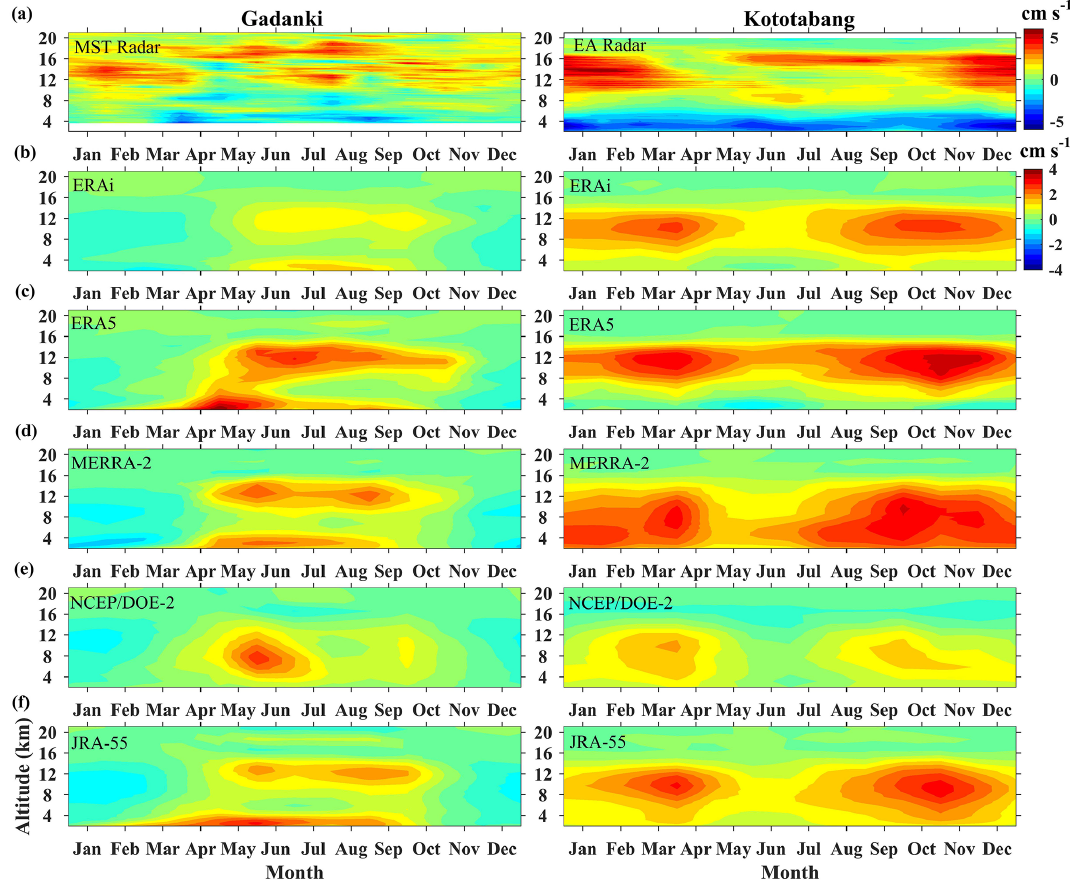
Figure A1. Monthly mean climatology of w obtained from (a) radars, (b) ERAi, (c) ERA5, (d) MERRA-2, (e) NCEP–DOE (R-2) and JRA- 55 over Gadanki (left) (1995–2015), and Kototabang (right) (2001–2015). Gadanki data are at 12:00UTC and Kototabang data are diurnal